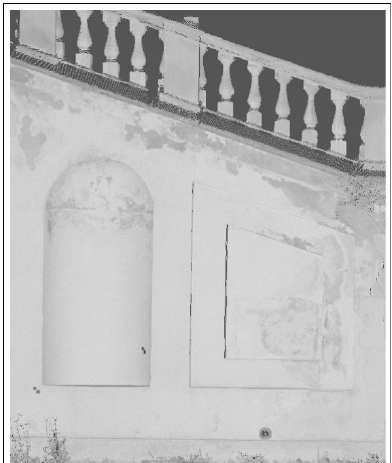
Figure 4: View of point-cloud pseudocolored with